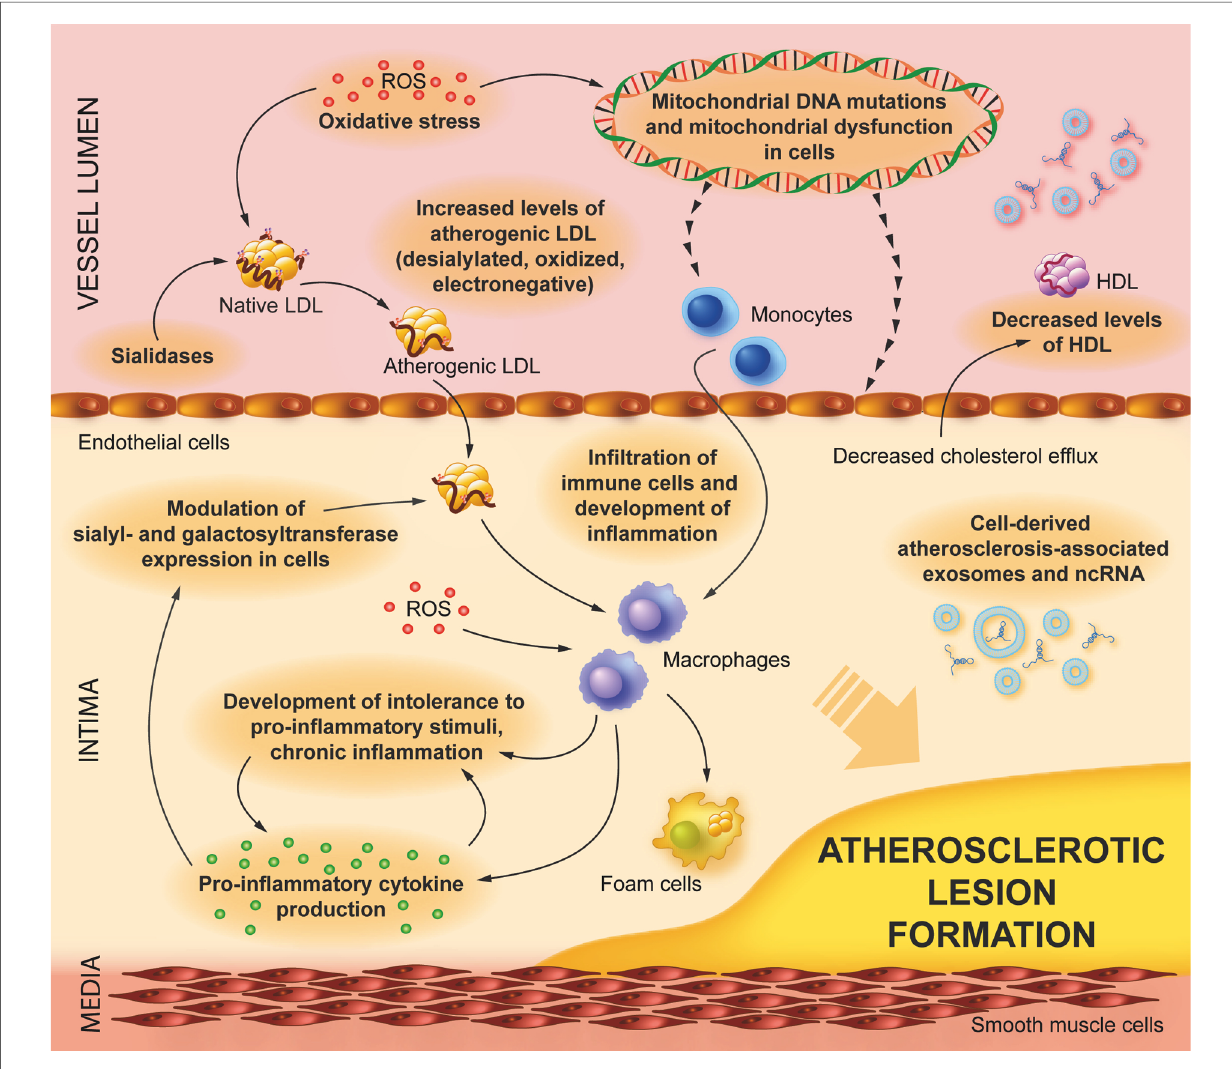
FIGURE 1 Pathological factors contributing to the development of atherosclerosis. Atherogenic LDL (desialylated, oxidized, and electronegative ones) induces lipid accumulation in endothelial cells and in fi ltrating macrophages, leading to foam cell formation, in fl ammation, and further progression of atherosclerosis. There are additional factors that contribute (or potentially contribute) to the development of atherogenesis, such as low levels of HDL, sialidase, and sialyl/ galactosyltransferase activities leading to the generation of atherogenic LDL, intolerance to pro-in fl ammatory stimulation (including stimulation by atherogenic LDL), atherosclerosis-associated non-coding RNA (ncRNA), and